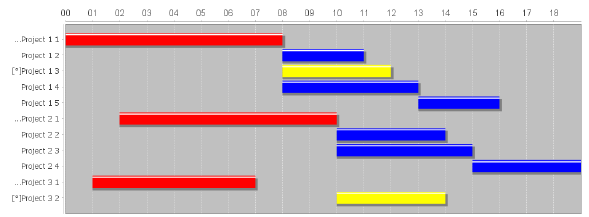
Figure 4: Order execution schedule - example with a look-ahead; decision on resource allocation made within deadline t l =